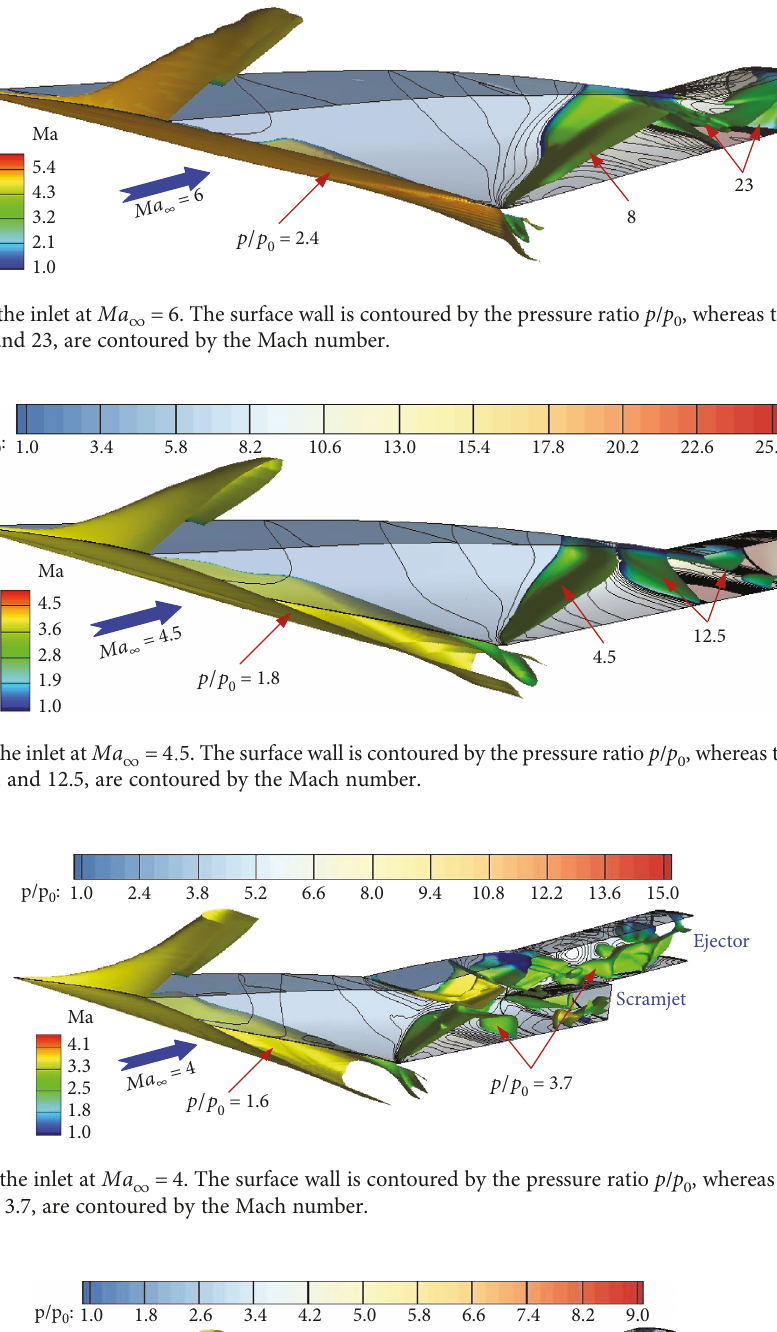
, whereas the two isobaric surfaces, 0